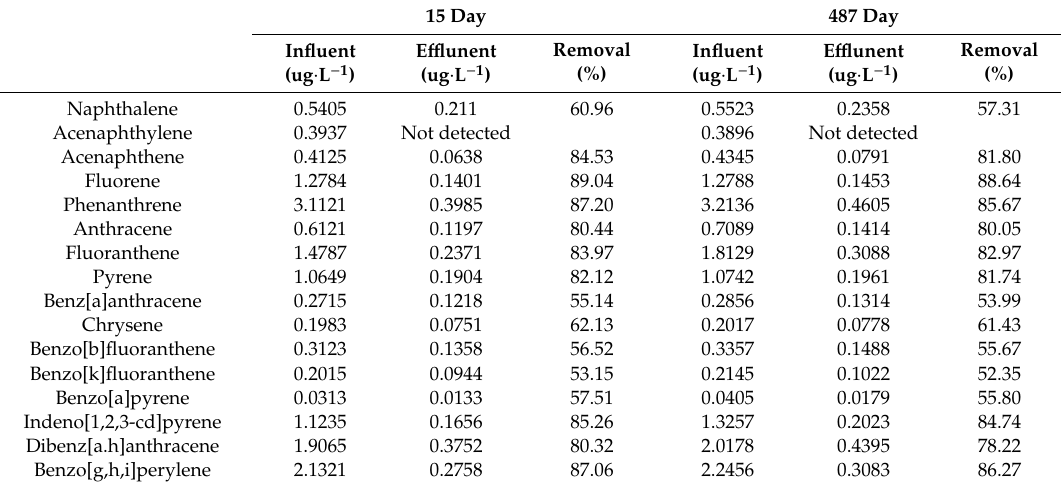
Table 5. The concentration of polycyclic aromatic hydrocarbons (PAHs) in the influent (BCW) and e ffl uent samples for di ff erent running